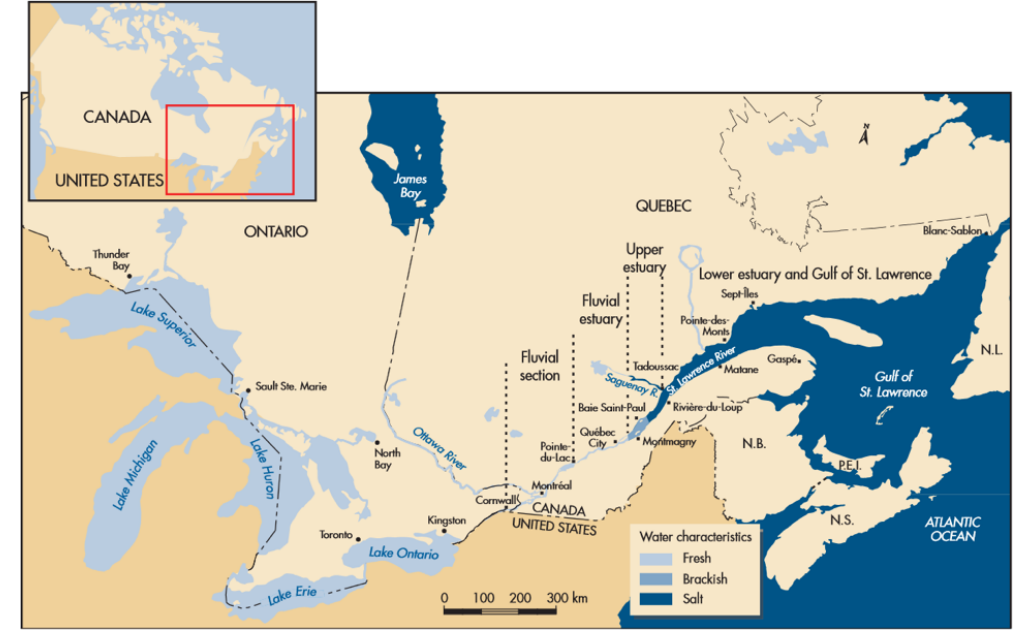
Figure 1. Map of the greater St. Lawrence system, including the chain of Great Lakes, the St. Lawrence River, the upper St. Lawrence Estuary (USLE), the lower St. Lawrence Estuary (LSLE), and the Gulf of St. Lawrence (GSL) (Working Group on the State of the St. Lawrence Monitoring, 2014, with